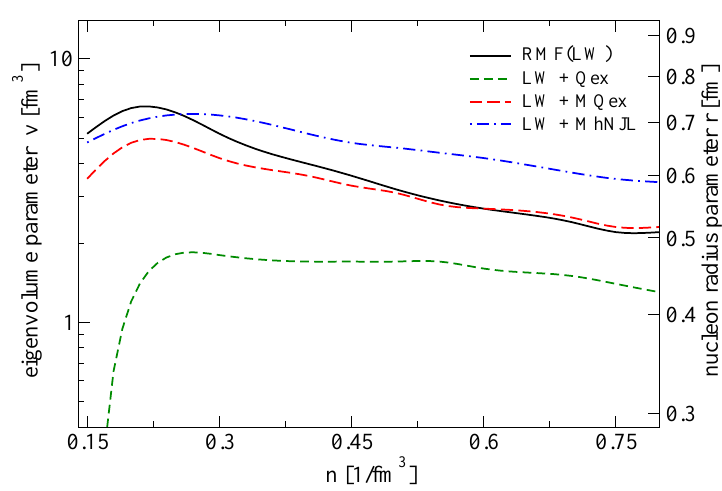
Figure 7. Density dependence of the nucleonic eigenvolume parameter v that would reproduce the quark Pauli blocking EoS of the present approach for the DD2 EoS with excluded volume from [12]. Identifying the eigenvolume parameter with the van-der-Waals excluded volume v = 16 π r 3 /3 one can extract a nucleon radius parameter r shown on the alternative axis.